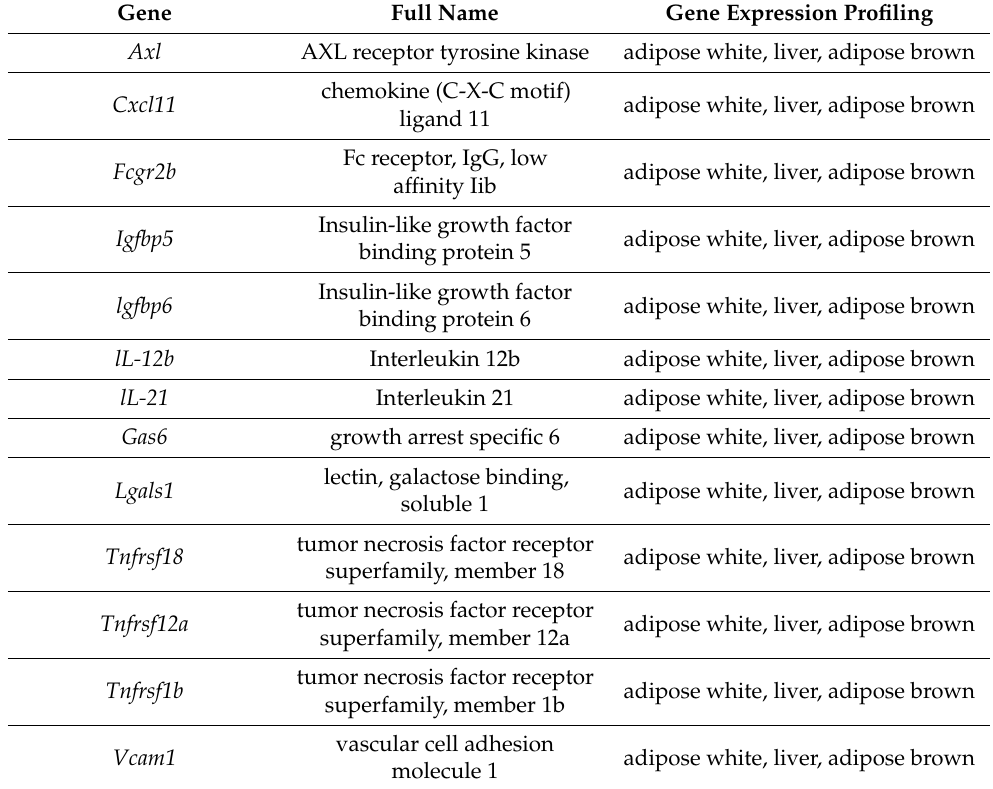
Table 2. Gene expression profile in the tissues